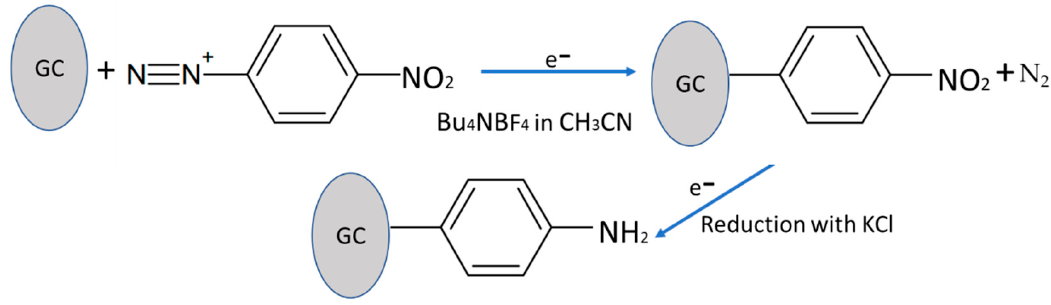
Table 1. 4-p-nitrophenyl surface coverage on carbon-based substrates. Substrate